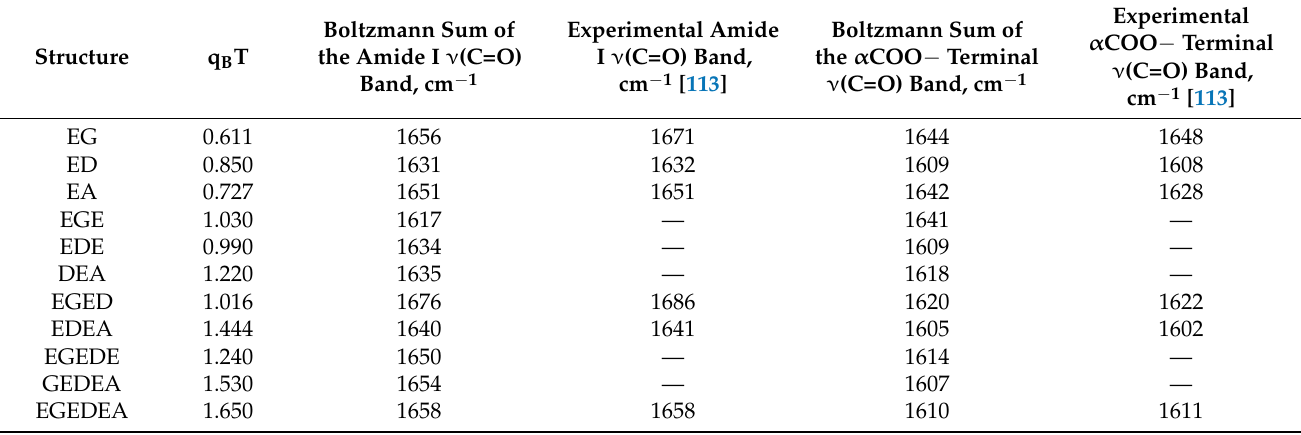
Figure 2. Comparison of the experimental Raman spectrum to the Boltzmann-summed simulated Raman spectrum for the ( a ) EG, ( b ) ED, ( c ) EA, ( d ) EGED, ( e ) EDEA, and ( f ) EGEDEA peptide fragments, presented in wavenumbers, cm − 1 . Table 2. Boltzmann sums of the total charge transferred via intramolecular hydrogen bonding (q B T), in millielectrons, e − , along with the Boltzmann sums of the amide I and α COO − terminal ν (C=O) band positions for each peptide fragment of interest compared to the experimental Raman band positions, in wavenumbers, cm − 1 , from our previous investigation. Data reproduced with permission under license